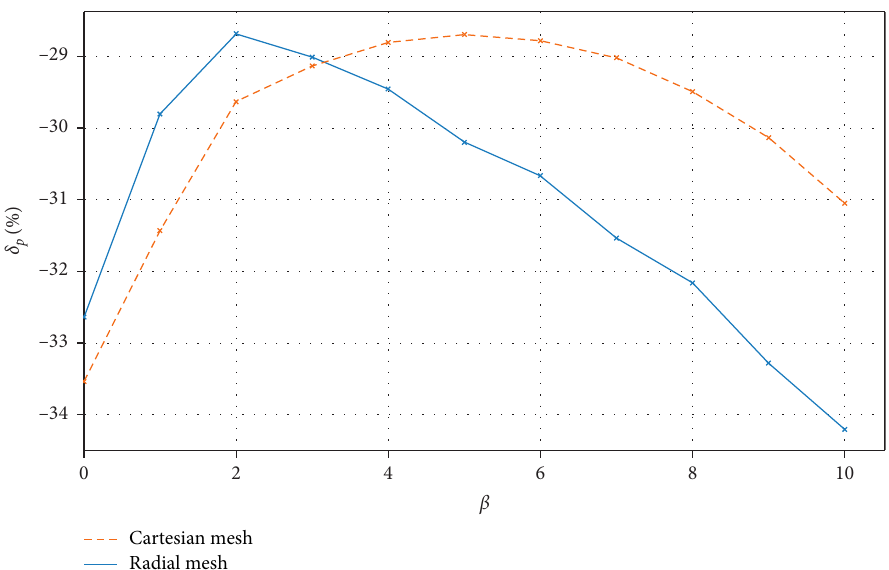
Figure 9: Pressure average error with UFC-3-340-2 as a function of balloon size β.